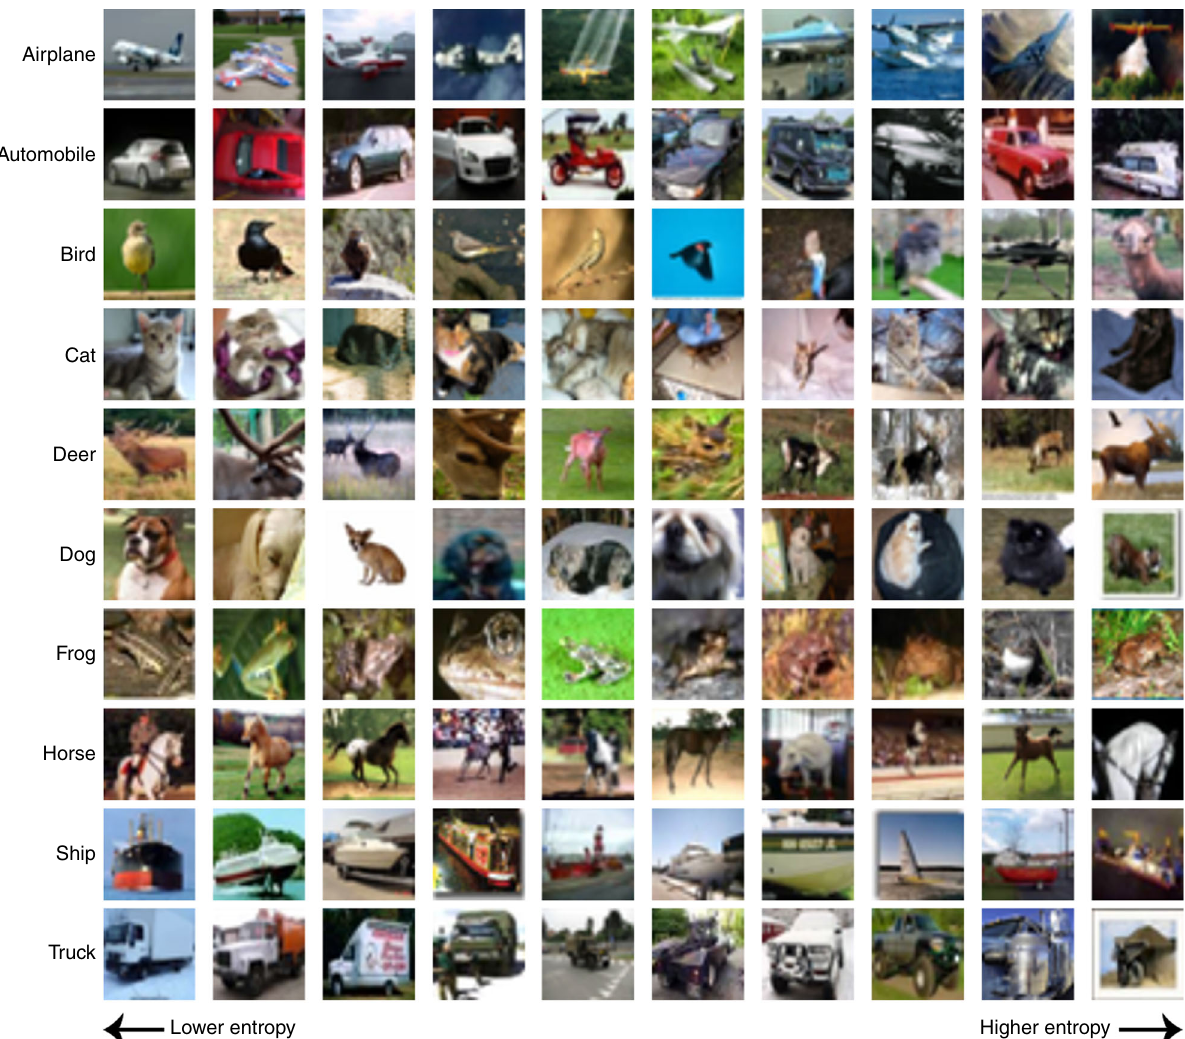
Fig. 2 Stimuli for current study. Ten representative natural images from each of the categories we use in our experiments, arranged by the entropy of their associated human categorizations. Images were taken from the CIFAR-10 test set 49 and clustered into ten entropy bins, with the same minimum and maximum entropy used for all categories. Representative images were then chosen from each bin, for each category. Lower entropy means a higher degree of human categorization